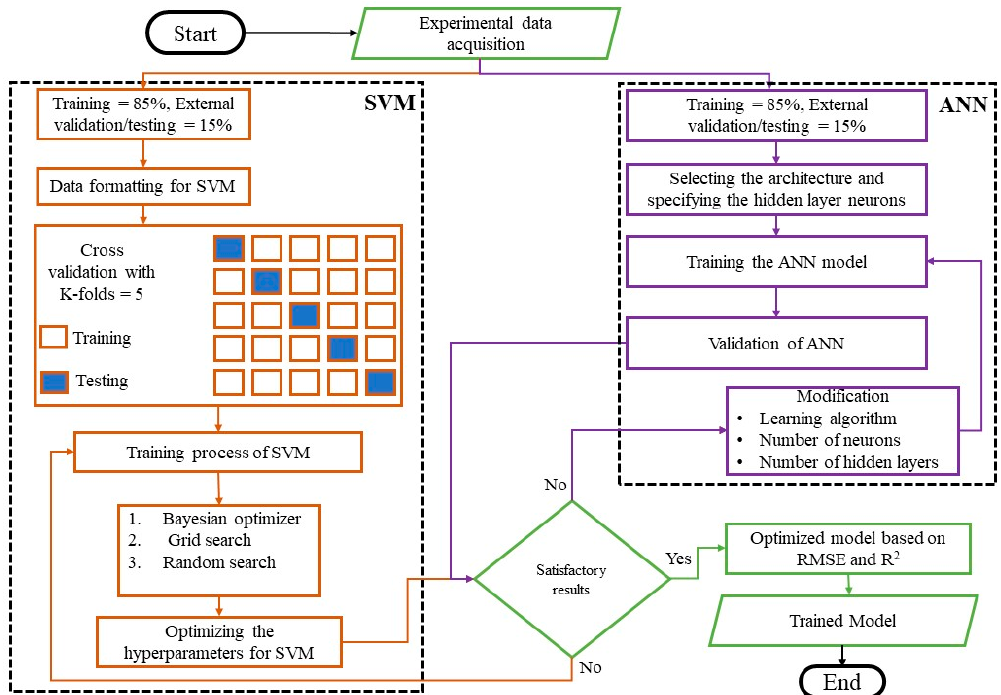
Figure 2. Process flow of artificial neural network and support vector machine.